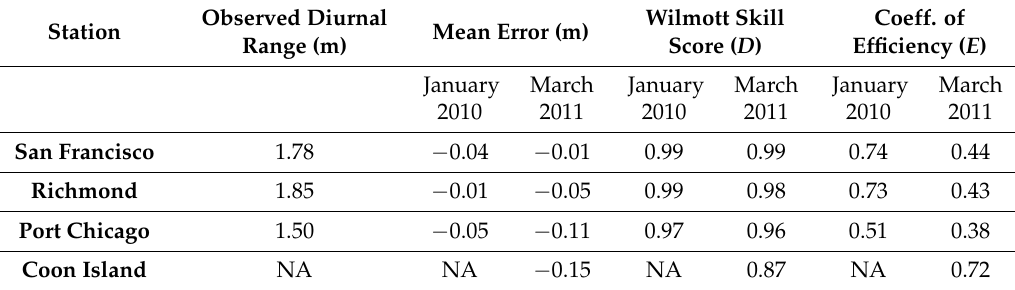
Table 4. Skill statistics comparing modeled and observed water